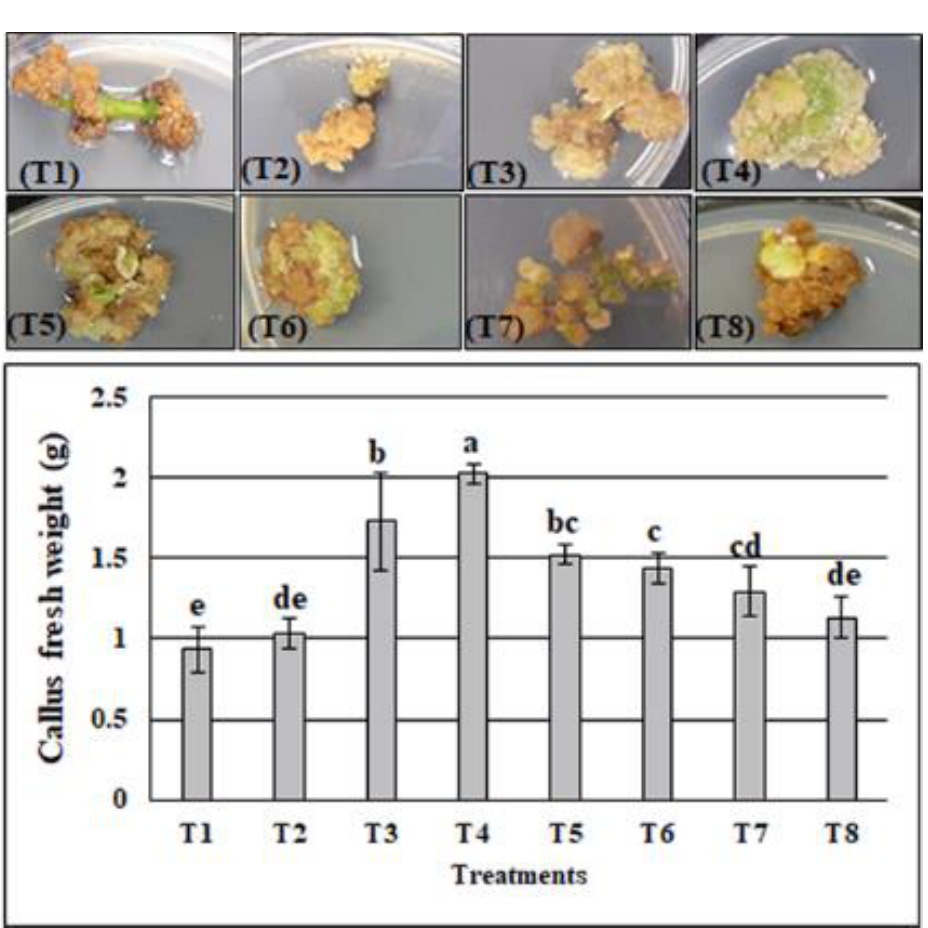
Figure 2. Effect of plant growth regulators on callus morphology and fresh weight after 8 weeks of cultures (T1 — 0.5 µM BA + 0.5 µM 2,4-D; T2 — 0.5 µM BA + 1 µM 2,4-D; T3 — 0.5 µM BA + 2.5 µM 2,4-D; T4 — 0.5 µM BA + 5 µM 2,4-D; T5 — 1 µM BA + 0.5 µM 2,4-D; T6 — 2.5 µM BA + 0.5 µM 2,4-D; T7 — 5 µM BA + 0.5 µM 2,4-D; T8 — 5 µM BA + 5 µM 2,4-D; BA — 6-benzyladenine; 2,4-D — 2,4-dichloro-